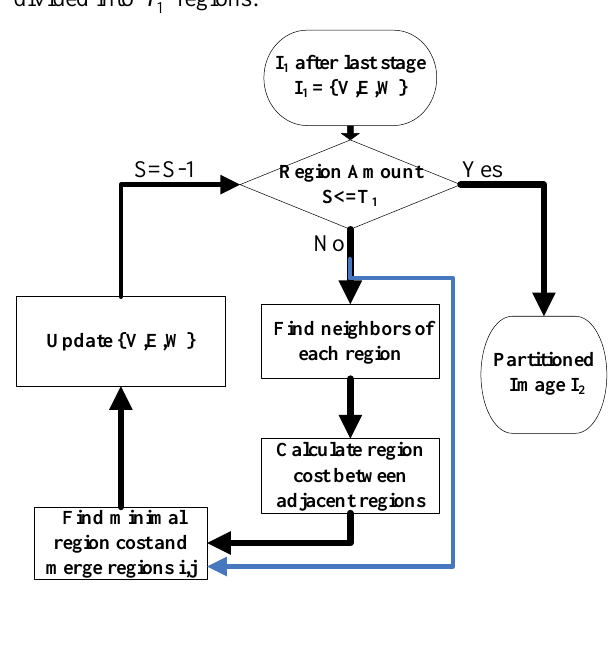
Fig 7. Region cost calculation